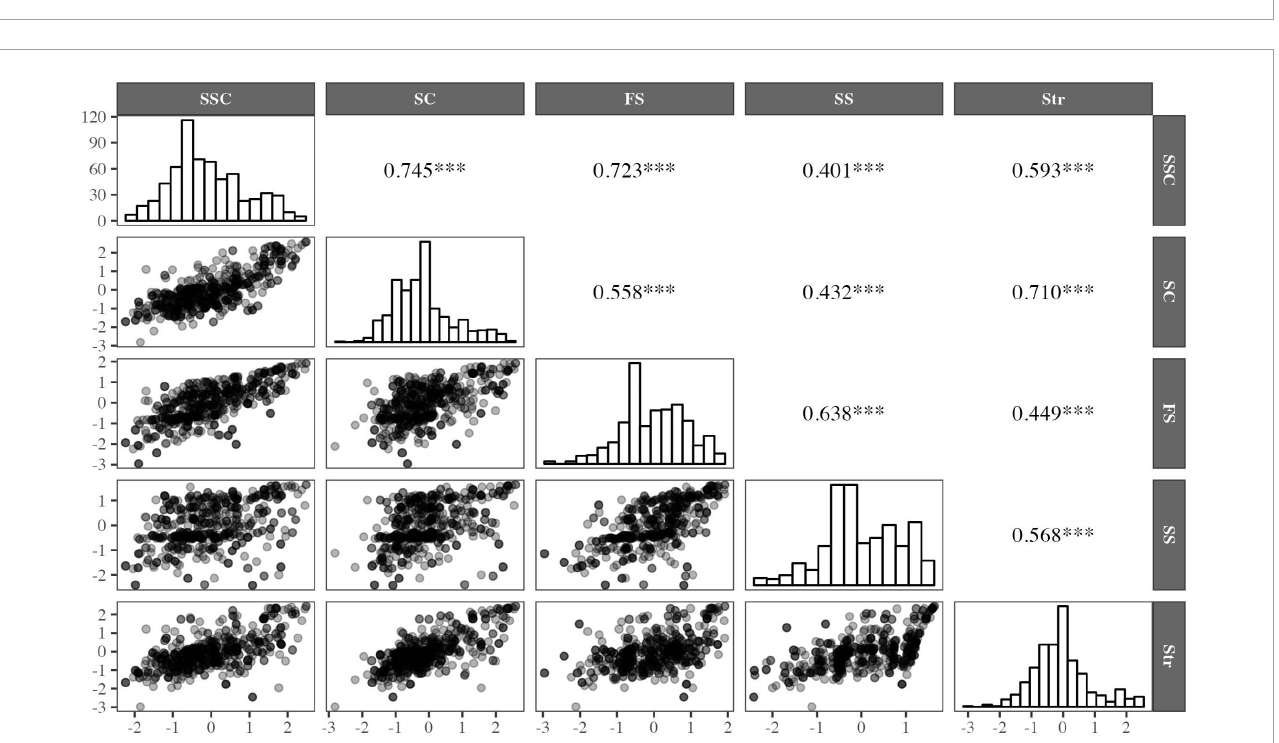
FIGURE2 Test information functions (TIFs) for the five factors of the RESI-M.